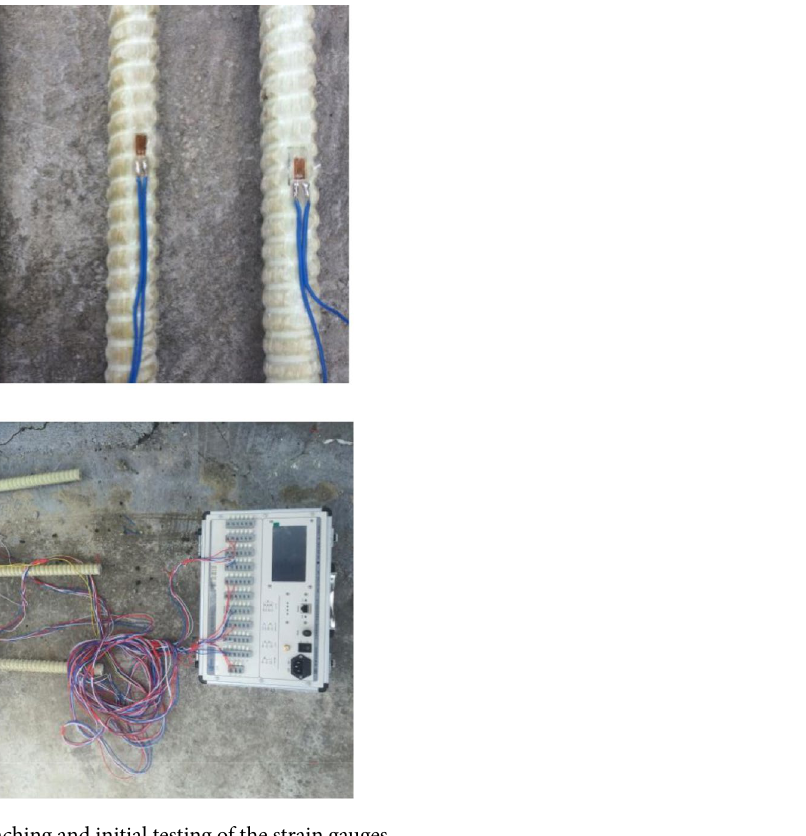
Figure 15. Attaching and initial testing of the strain